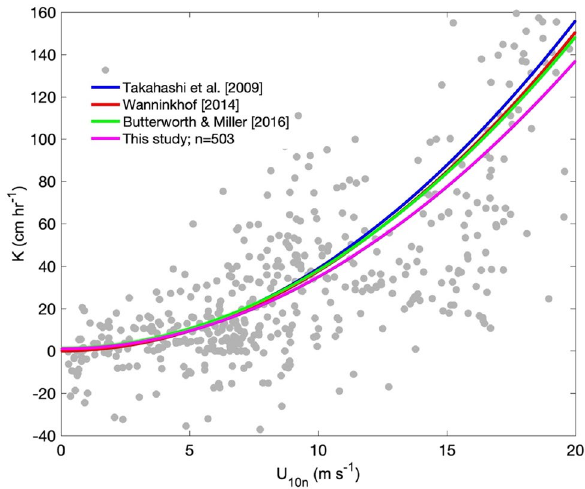
Figure 7. Relationship between the CO 2 transfer velocity coefficient and the neutral wind speed at 10 m calculated from the data collected in this experiment. The quadratic fitted curve K = 0.34.U 10n 2 – 0.32 U 10n + 0.94 with r 2 = 0.75 is represented by the magenta line. The blue, red and green curves represent the CO 2